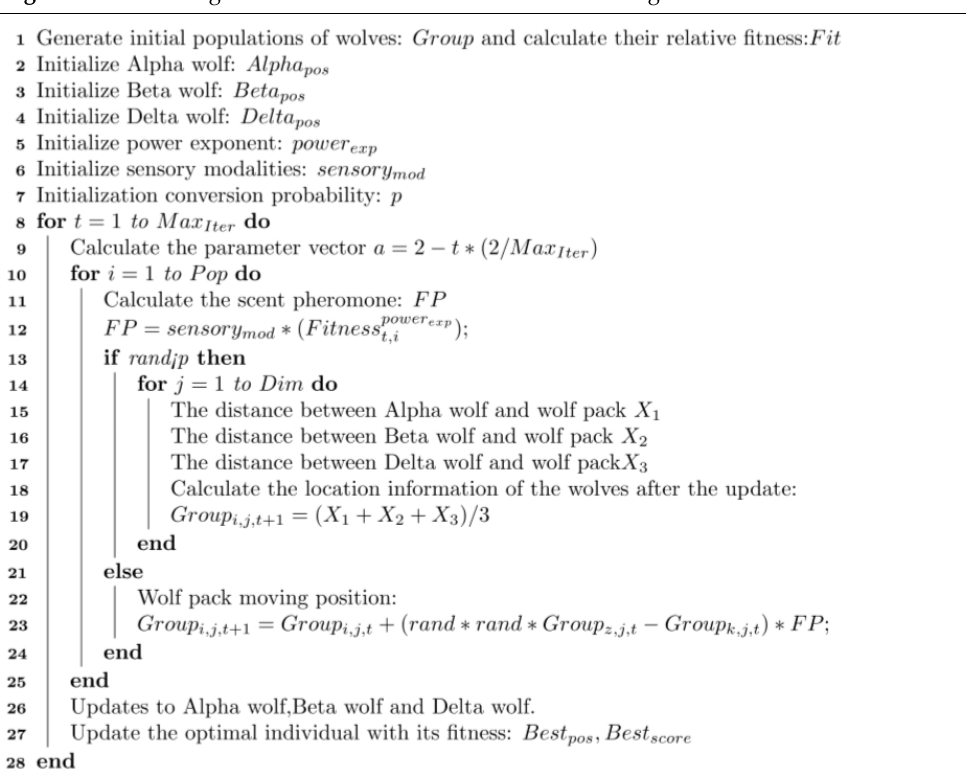
Algorithm 2 GWO algorithm based on the randomized wandering law